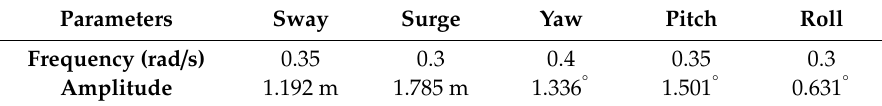
Table 1. Single-frequency six DOF oscillation motion parameters for wave frequency (WF).